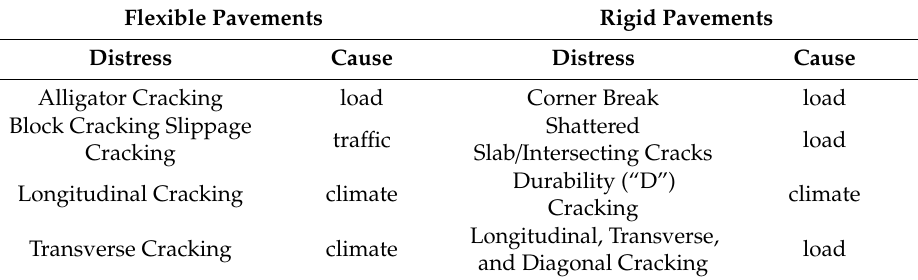
Table 1. Types of cracks in road pavements.